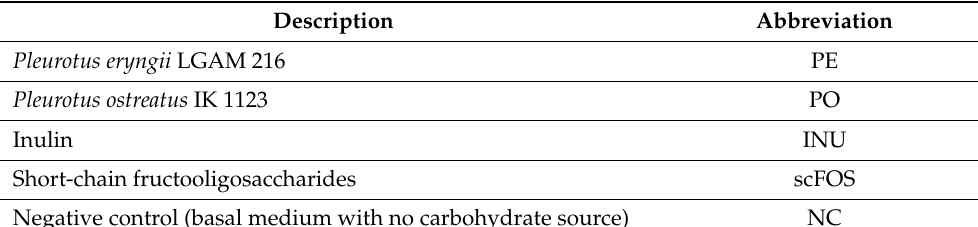
Table 1. Substrates used in the experiments. Description Abbreviation